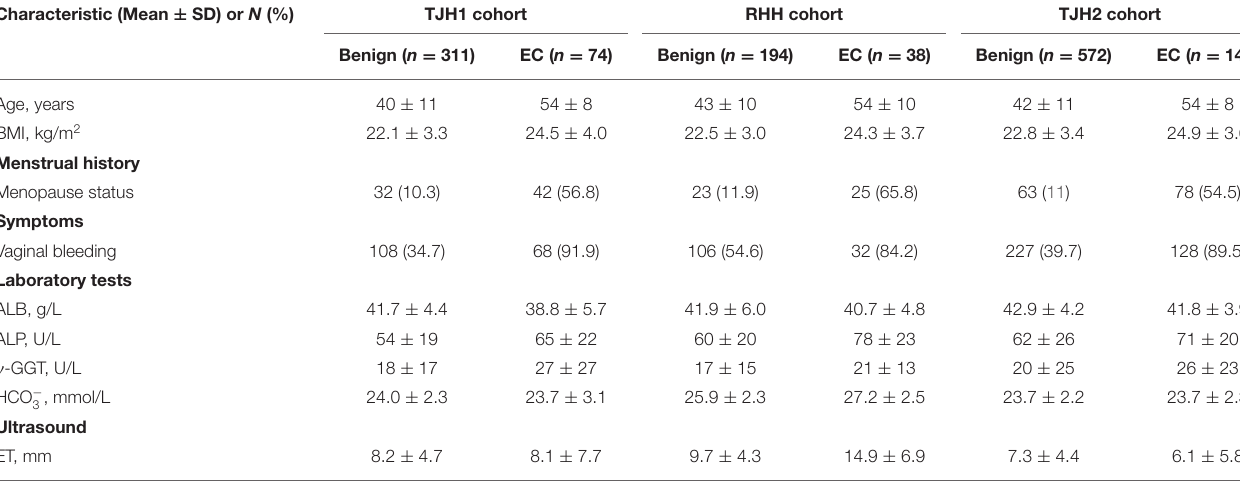
TABLE 1 | Demographic characteristics in the validation cohorts.